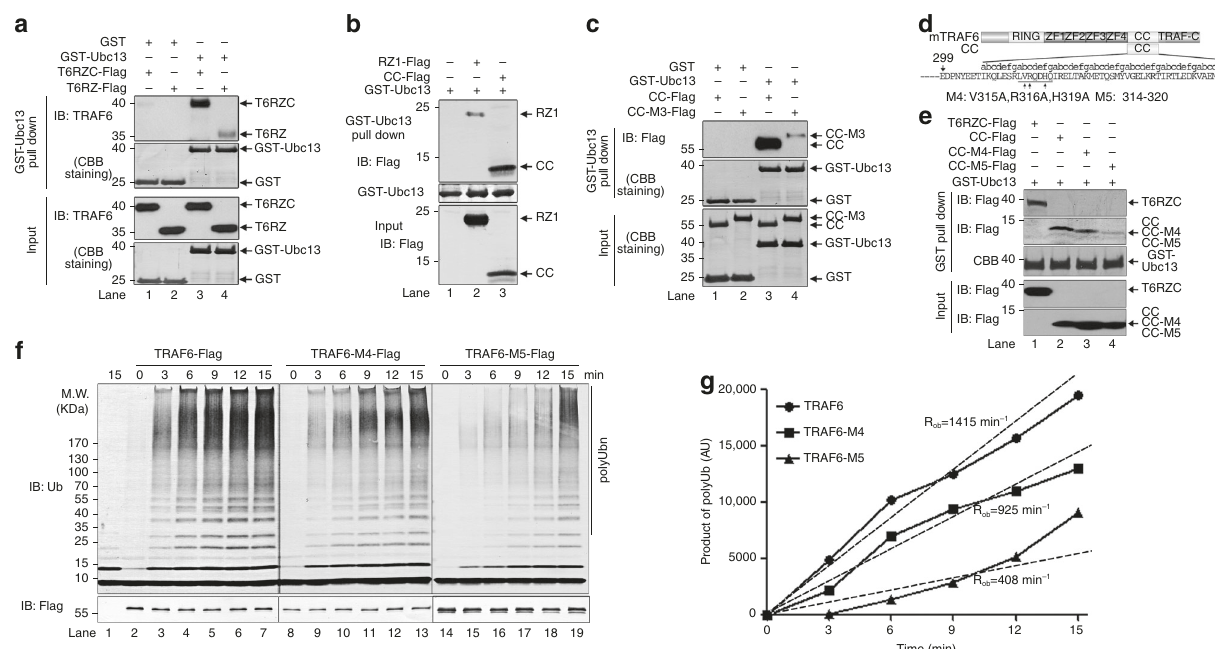
Fig. 6 Oligomerized CC domains interact with Ubc13 contributing to processivity of TRAF6 E3 activity. a CC domain contributes to the interaction between TRAF6 and Ubc13. GST or GST-Ubc13 was incubated with puri fi ed T6RZC or T6RZ proteins and subjected to GST pull-down assays. Bound proteins were analyzed by immunoblotting with the indicated antibodies. b CC domain binds more Ubc13 than RZ1 does. HEK293T/TRAF6 KO cell lysates expressing Flag-tagged RZ1 or CC were mixed with GST-Ubc13 and subjected to GST pull-down assay. Bound products were immunoblotted with the indicated antibodies. c Oligomerized CC domains bind more Ubc13. GST or GST-Ubc13 was mixed with puri fi ed CC-Flag or CC-M3-Flag and subjected to GST pull- down assay. Bound proteins were immunoblotted with the indicated antibodies. d TRAF6 CC domain mutants M4 and M5 are depicted. e Impaired interaction between CC mutants and Ubc13. HEK293T/TRAF6 KO cell lysates expressing T6RZC-Flag, CC-Flag, CC-M4-Flag, or CC-M5-Flag were mixed with GST-Ubc13 and subjected to GST pull-down assay. Bound products were immunoblotted with the indicated antibodies. f , g TRAF6 mutants M4 and M5 display decreased rate of polyubiquitin chain assembly. Time-course analysis of polyUb chain synthesis was performed to compare TRAF6,